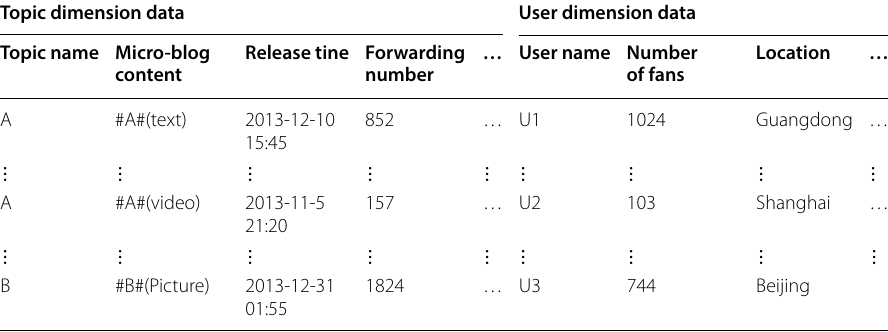
Table 2 Data structure and fields Topic dimension